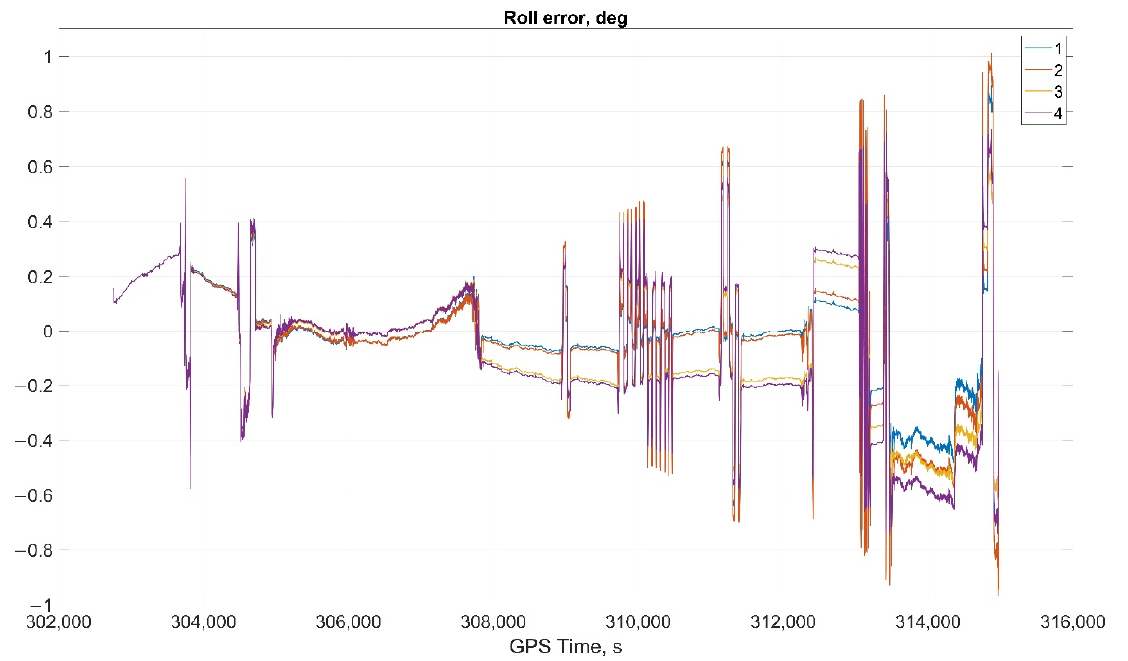
Figure 12. Roll error in car test (1, Transformation matrix approach; 2, Direct angles calculation approach; 3, Transformation matrix approach using GNSS data; and 4, Direct angles calculation approach using GNSS data).